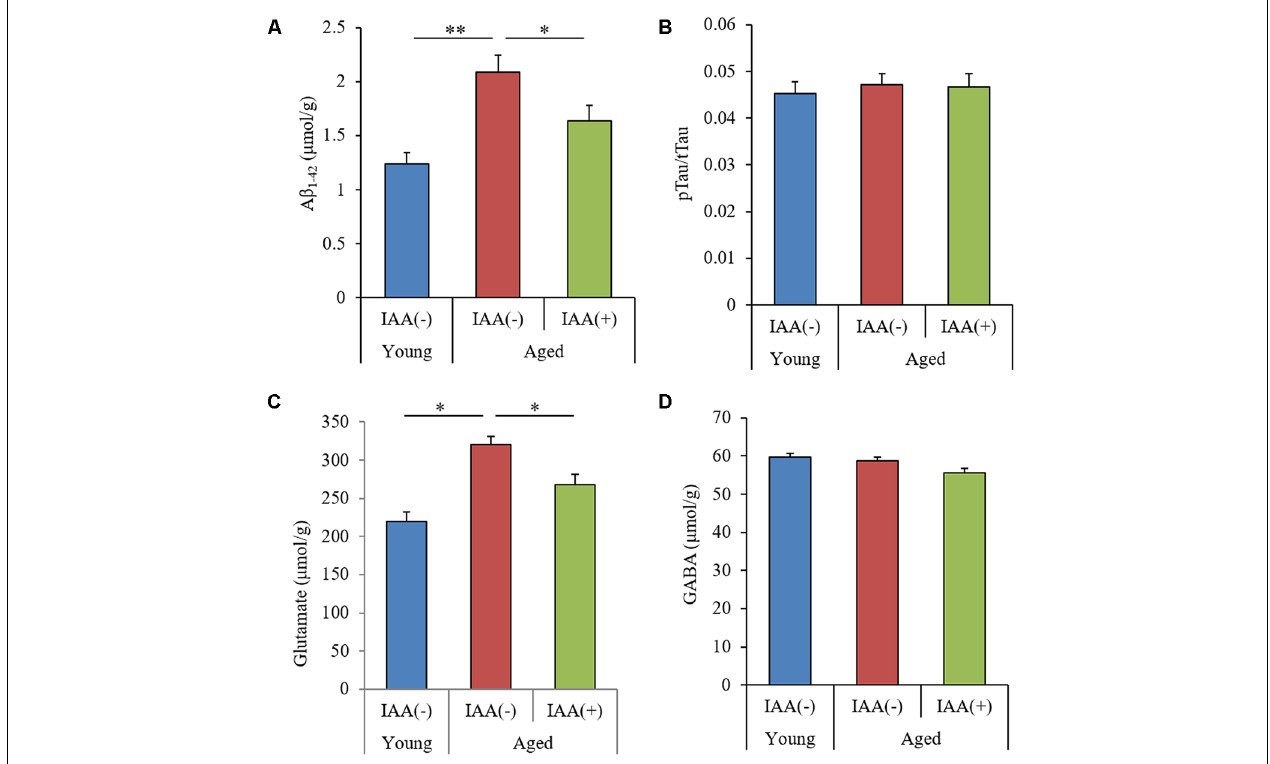
FIGURE 3 | Levels of amyloid β (A β ), Tau, and glutamate in the hippocampus of aged mice. We fed C57BL/6J mice aged 7 weeks (young) and 68 weeks (aged) diets containing 0% or 0.05% (w/w) IAA for 3 months and then obtained brain tissue for analysis from young mice ( n = 12) and aged mice with ( n = 10) or without ( n = 9) dietary IAA. (A,B) The levels of A β 1–42 (A) and phosphorylated Tau to total Tau (pTau/Tau; B ) in TBS-soluble fractions of the hippocampus. (C,D) The amount of glutamate (C) and GABA (D) in the hippocampus. Data are presented as mean ± SE. We calculated the p -values shown in the graph by one-way ANOVA, followed by the Tukey-Kramer test. ∗ p < 0.05 and ∗∗ p <